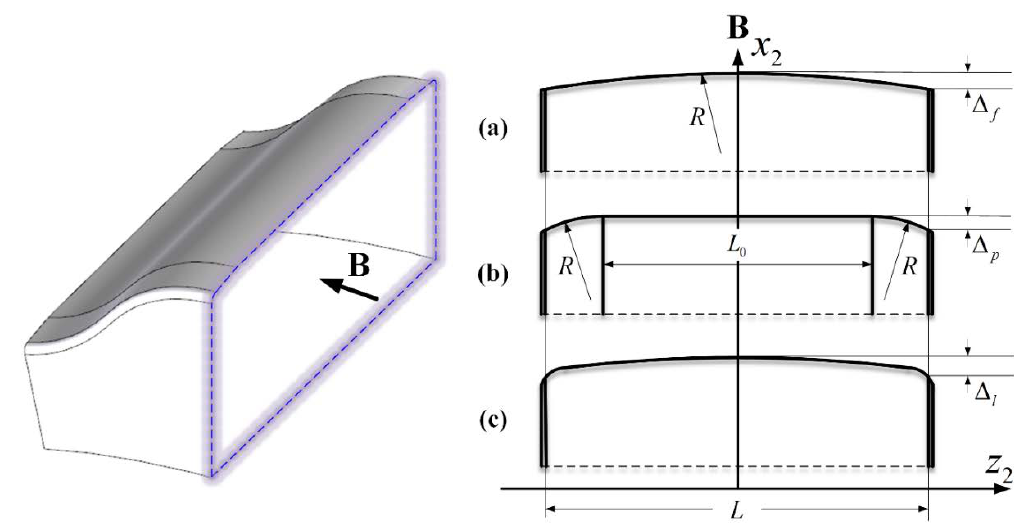
Figure 4. Three types of tooth longitudinal modifications for cycloid gears: ( a ) fully crowned modification (FCM), ( b ) partially crowned modification (PCM), and ( c ) logarithmically crowned modification (LCM).